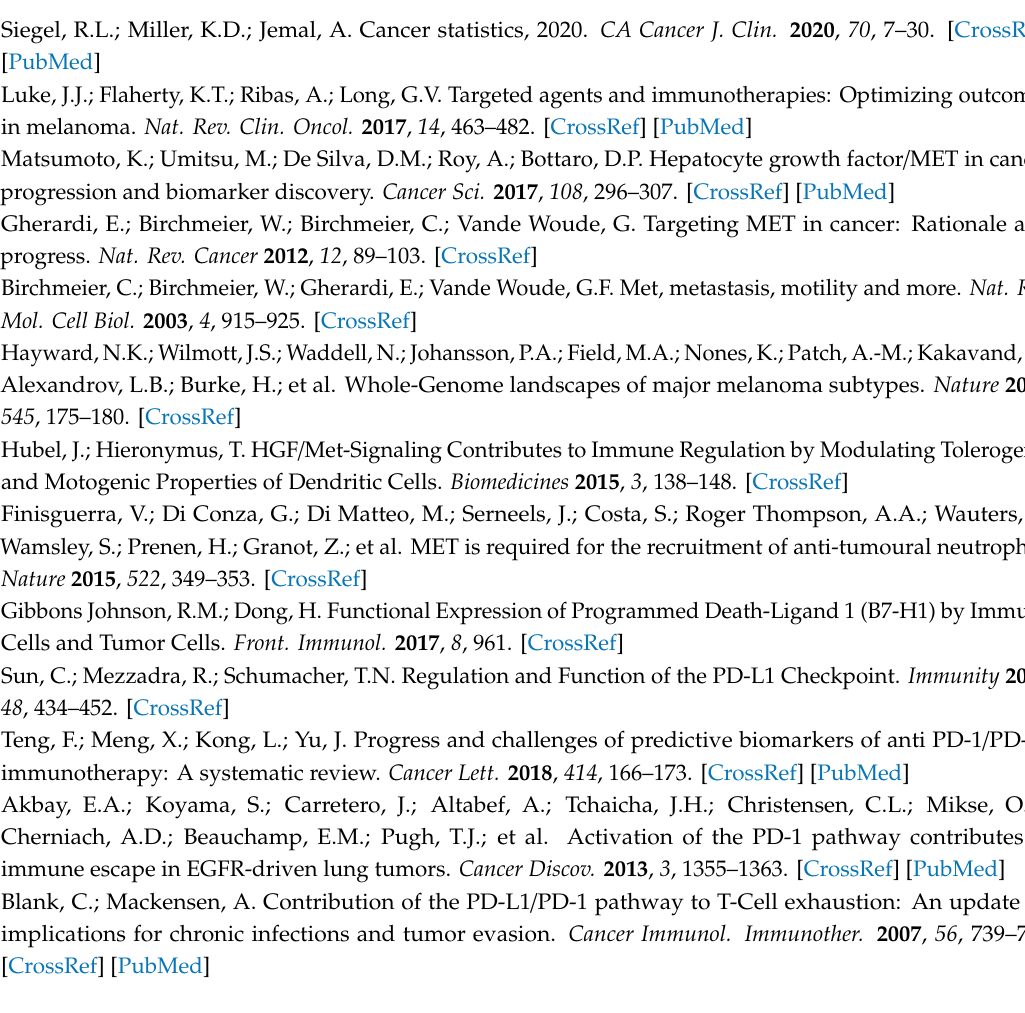
Figure S1. Tissue microarray images with marked position by rows and columns coordinates (see corresponding cases detailed in Table S4): hematoxylin and eosin (H&E), MET, and PD-L1 immunostained slides, Table S1. Median (with interquartile range) and range values for primary melanoma cell lines and metastatic melanoma cell lines, Table S2. Mean (with 95% confidence interval) and median (with interquartile range) for benign nevi, cutaneous melanoma, metastatic melanoma, and mucosal melanoma in the TMA, Table S3. Melanoma cell lines evaluated in the cell line microarray (CMA), Table S4. Demographic and available clinical information for the TMA